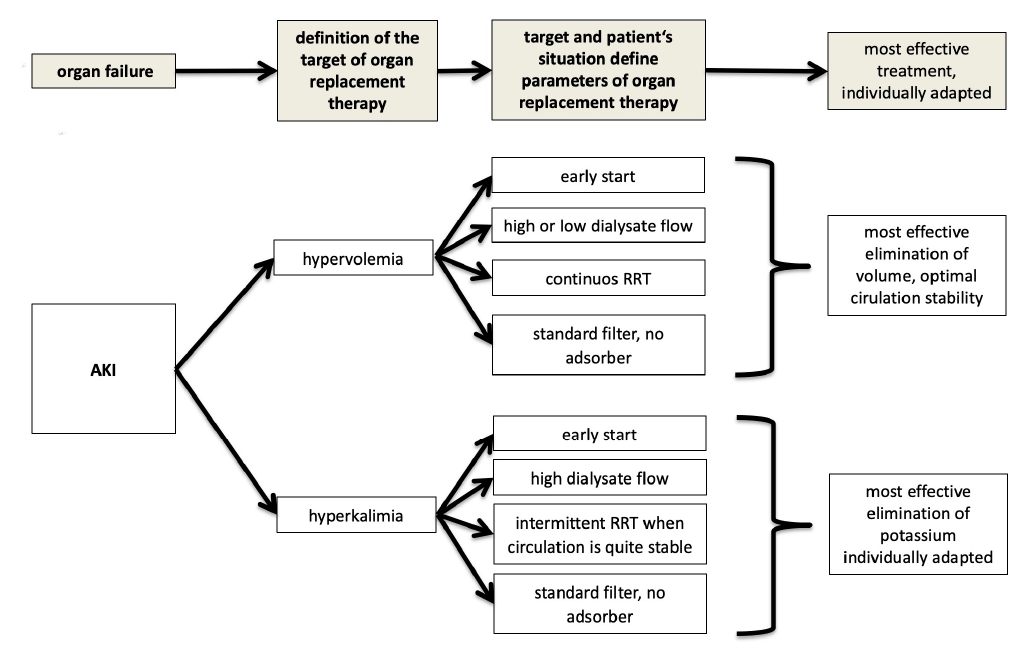
Figure 3. Individualized approach for RRT.